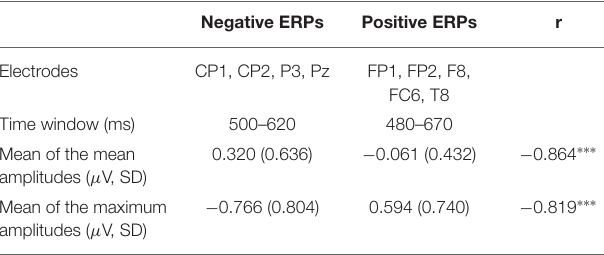
TABLE 5 | Effect sizes of the ERPs for a syntactic Island violation in In Syntactic Island for Quantifier First and their correlation coefficients with JRST scores. In Syntactic Island -